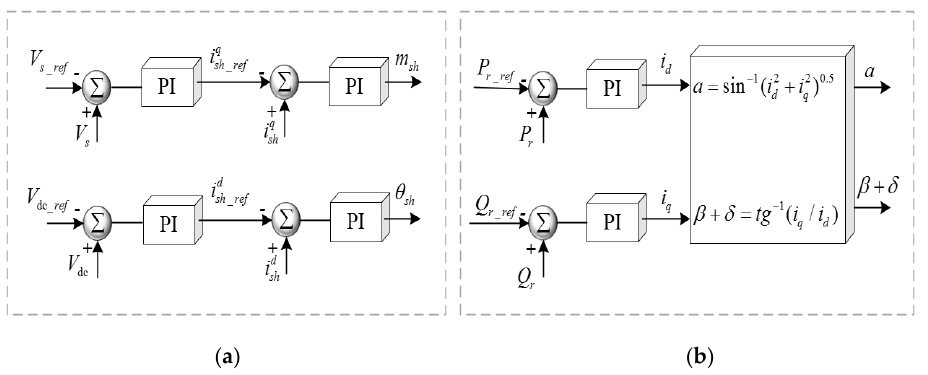
Figure 3. Block diagram of the proposed control system: ( a ) series converter control and ( b ) parallel converter control.